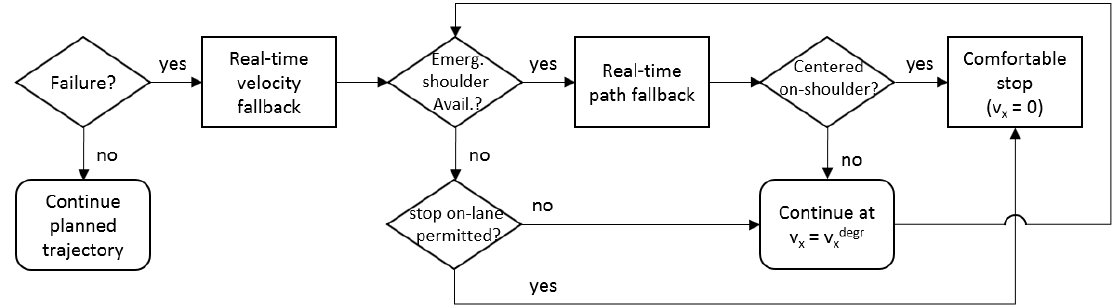
Figure 5. Flowchart on real-time trajectory